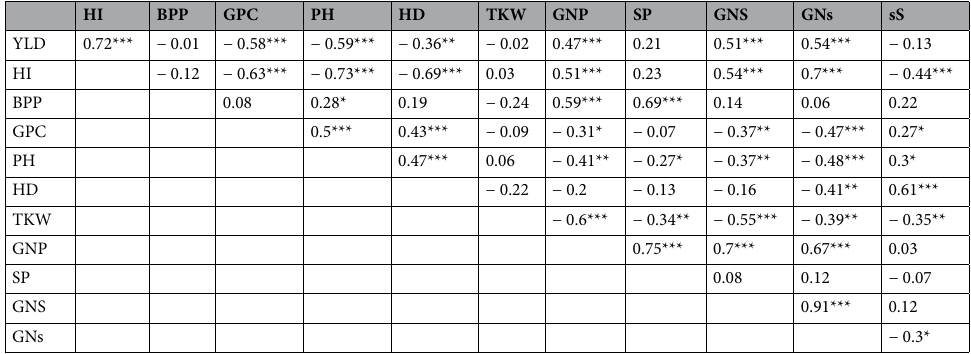
Table 4. Pearson’s correlation coefficients for 12 agronomic traits evaluated in 59 Argentinian durum genotypes in three environments. YLD grain yield, HI harvest index, BPP aerial biomass, GPC grain protein content, PH plant height, HD heading date, TKW thousand kernel weight, GNP grain number per plant, SP spikes per plant, GNS grain number per spike, GNs grain number per spikelet, sS spikelets per spike. * P < 0.05; ** P < 0.01; *** P <